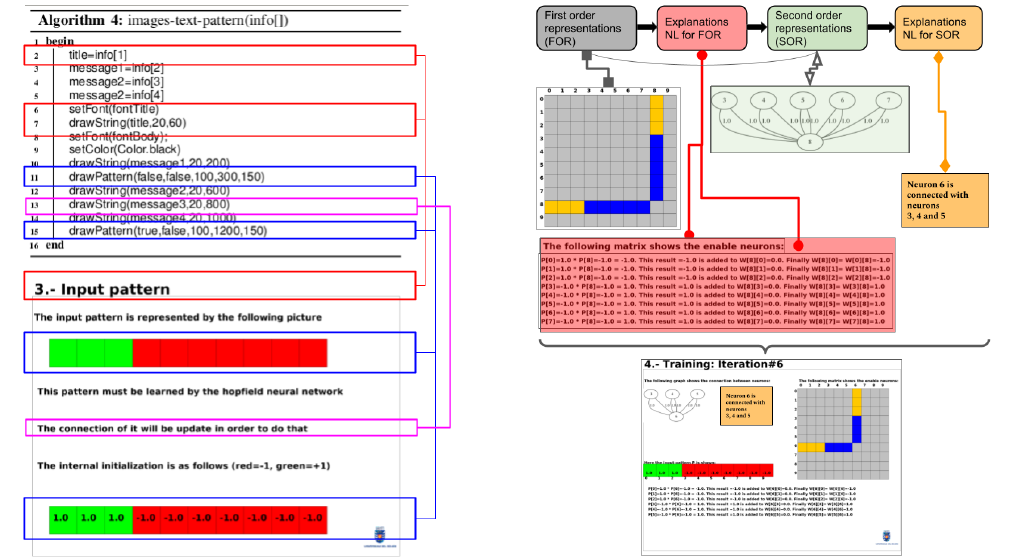
Figure 10. ( Left ) Frame generated using Algorithms A3–A5; ( Right ) A complete cycle of representa- tion for a frame extracted from a group of them whose objective is to explain the training phase.